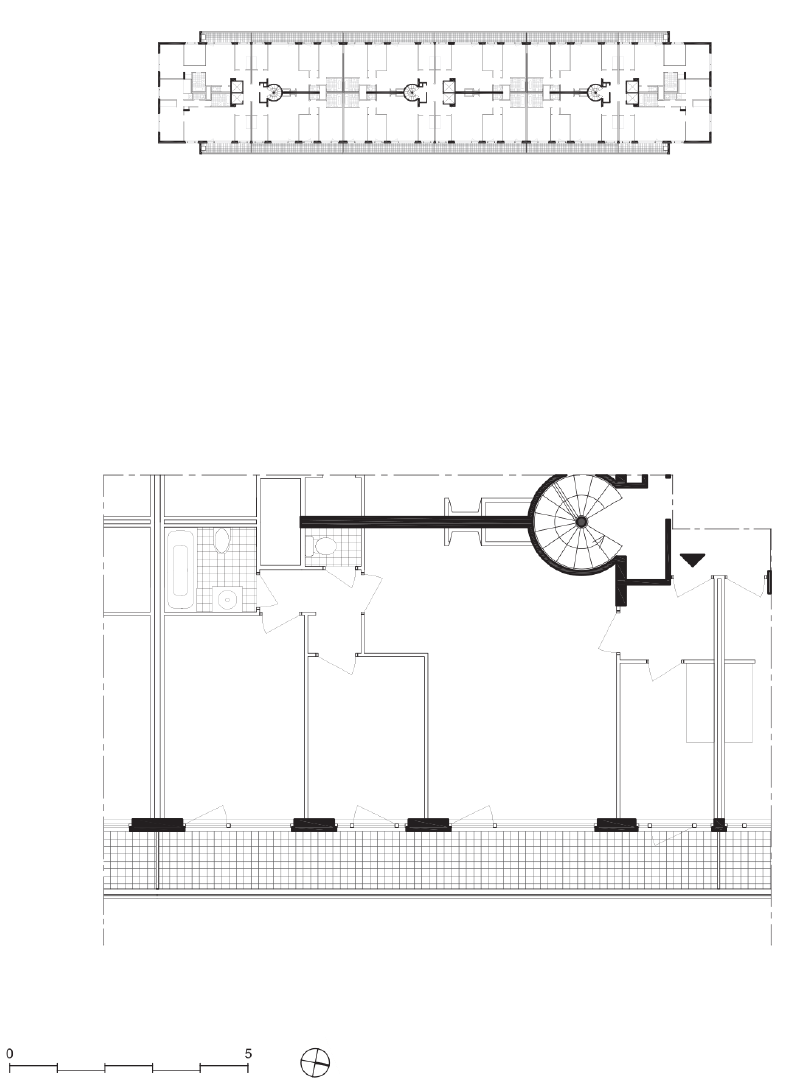
Figure 7. Etrimo, Parc Schuman , 1964 (drawings by the author). Boulevard Jacqmain as a pretext to build a